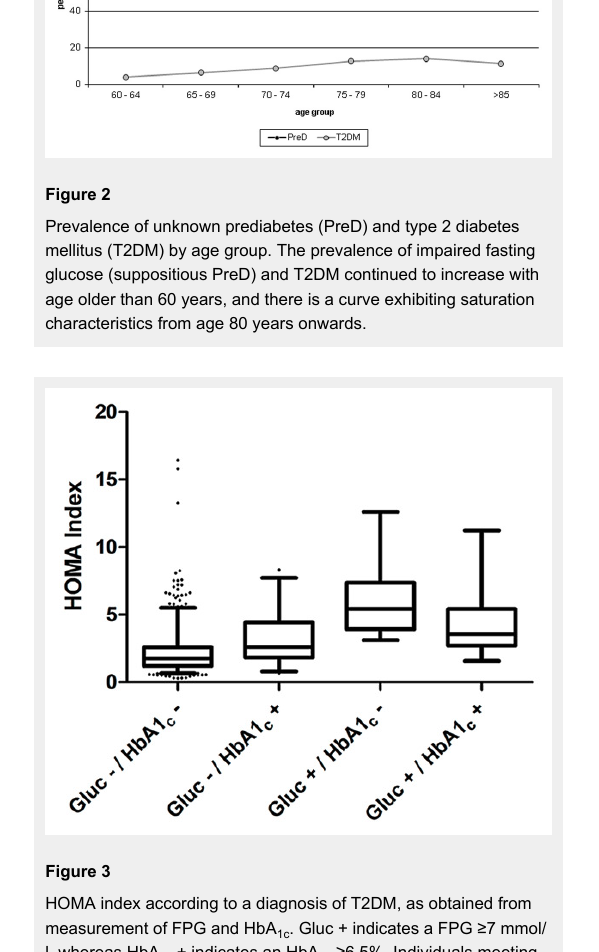
HOMA index according to a diagnosis of T2DM, as obtained from measurement of FPG and HbA 1c . Gluc + indicates a FPG ≥7 mmol/ l, whereas HbA 1c + indicates an HbA 1c ≥6.5%. Individuals meeting one or two diagnostic criteria had significantly higher HOMA indices than individuals without indication of T2DM. FPG = fasting plasma glucose; Gluc = glucose; HbA 1c = glycated haemoglobin; HOMA = homeostasis model assessment; T2DM = type 2 diabetes